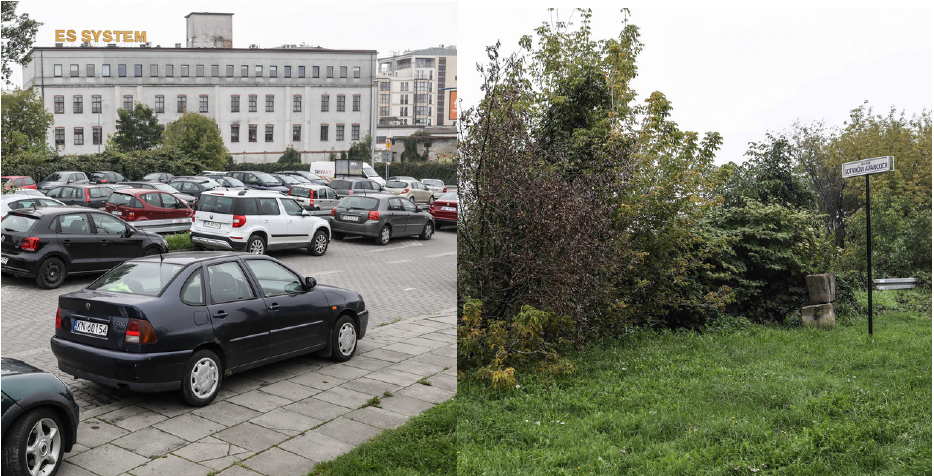
Figure 10. Plots constituting the main part of the development of the design of a multi-functional complex with objects and sites under the conservation (photo by E.